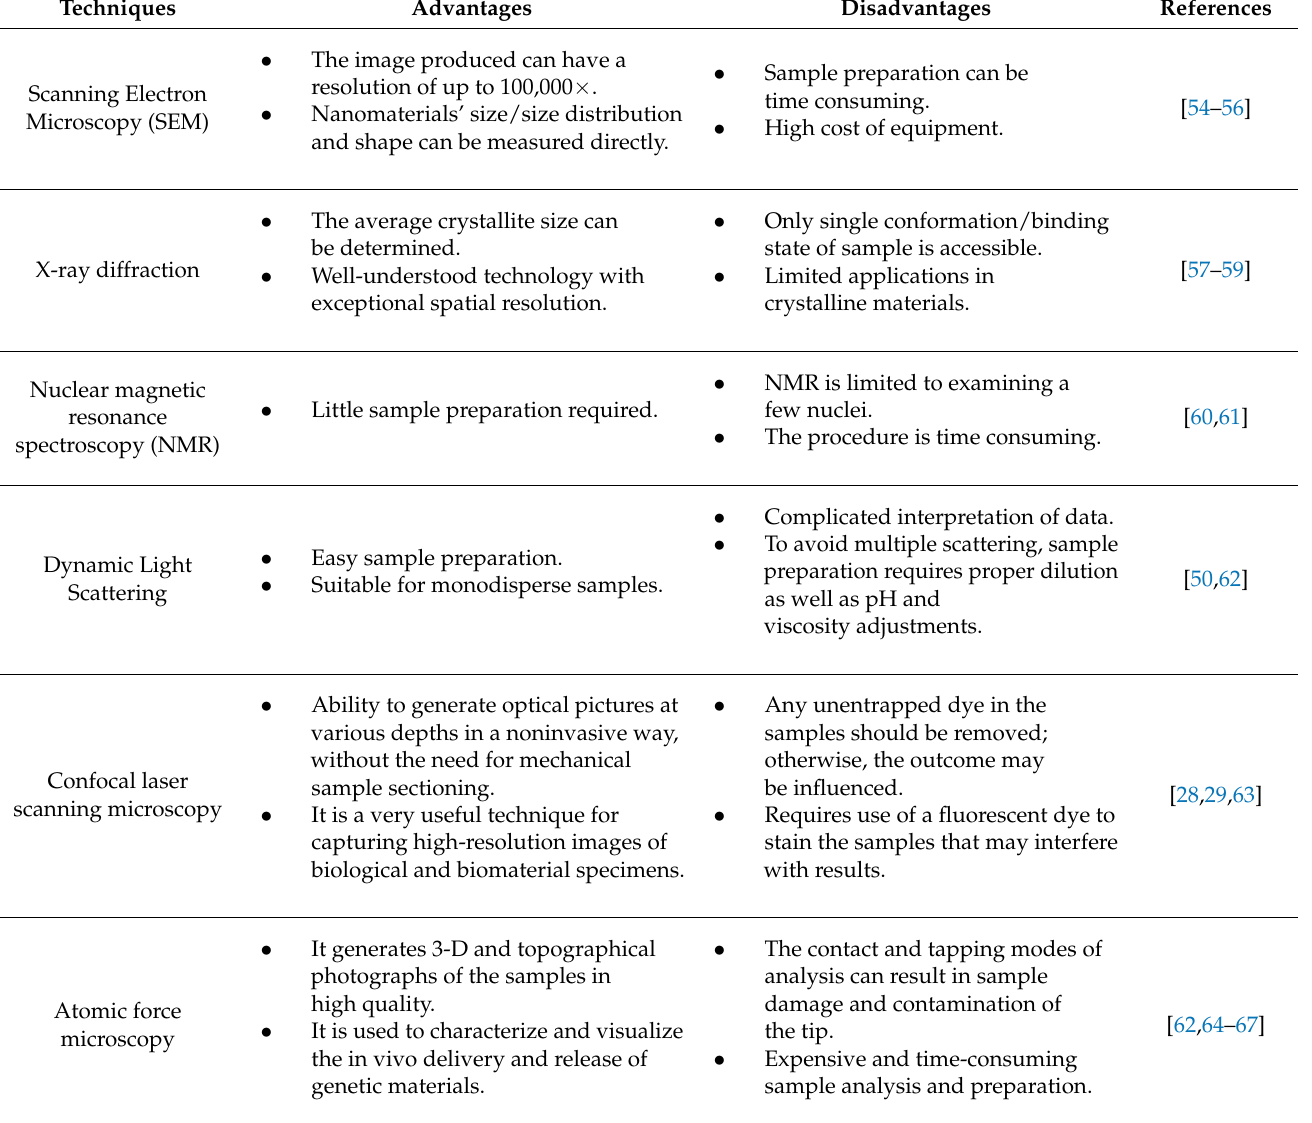
Table 2. Advantages and disadvantages of different non-destructive characterization